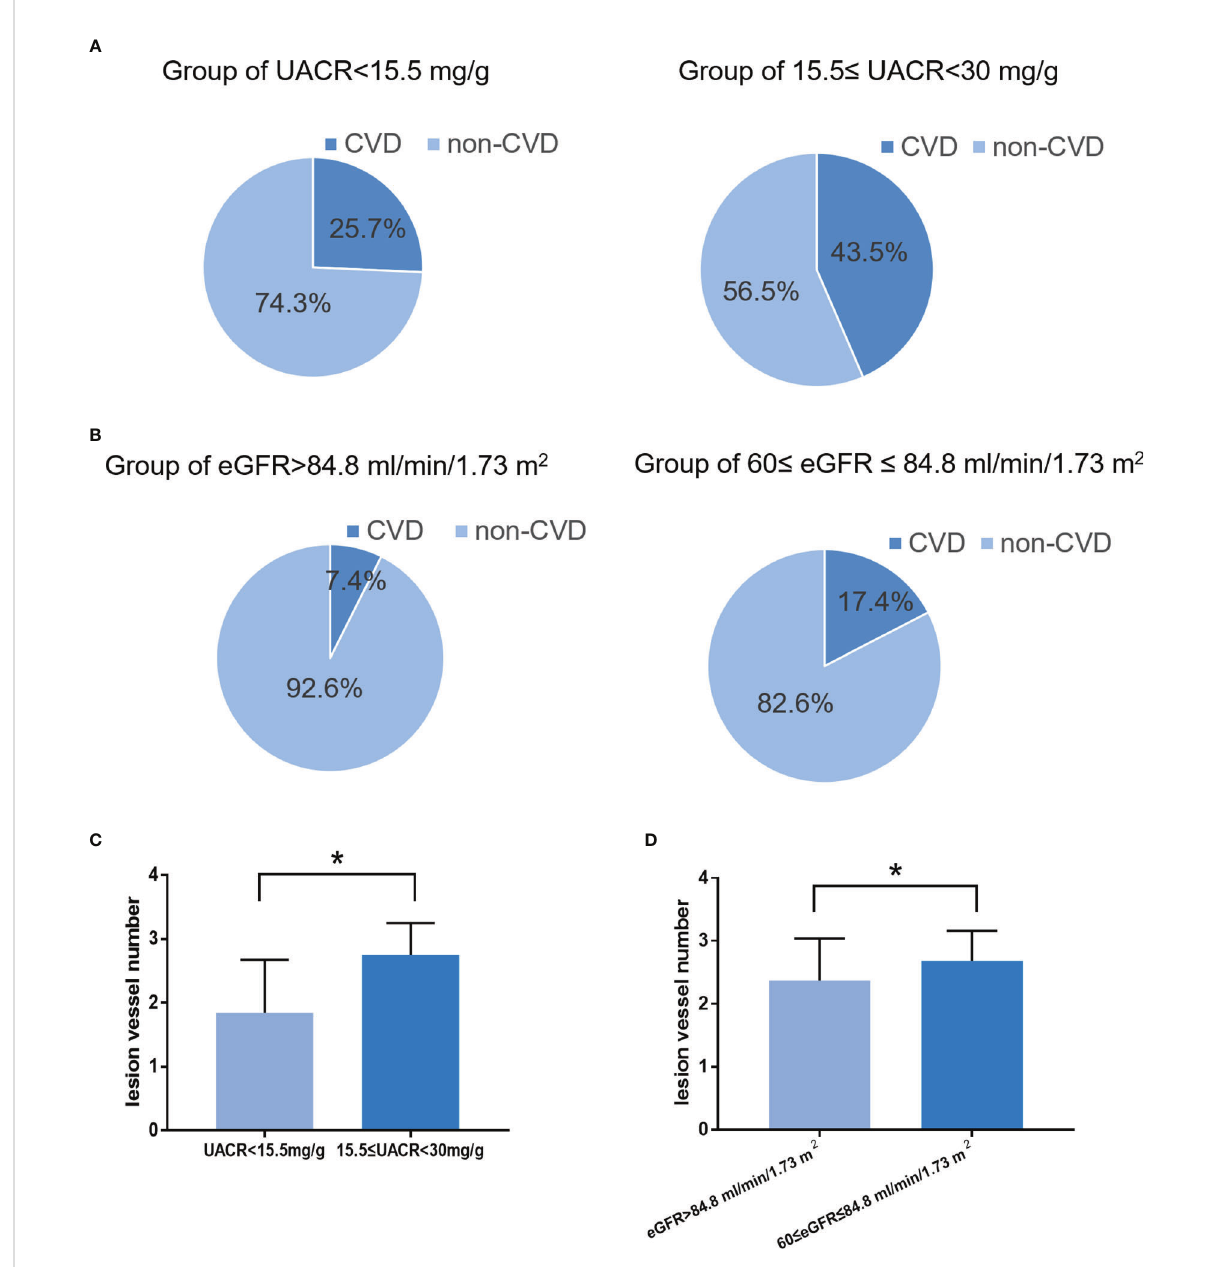
FIGURE 6 The incidence and severity of CVD in the low-risk and high-risk groups. (A) : The incidence and severity of CVD in the low-risk and high-risk groups according to the cut-off value of the UACR ( P < 0.05). (B) : The incidence and severity of CVD in the low-risk and high-risk groups according to the cut-off value of the eGFR ( P < 0.05). (C) : The severity of CVD in the low-risk and high-risk groups according to the cut-off value of the UACR ( P < 0.05). (D) : The severity of CVD in the low-risk and high-risk groups according to the cut-off value of the eGFR ( P < 0.05). * P <